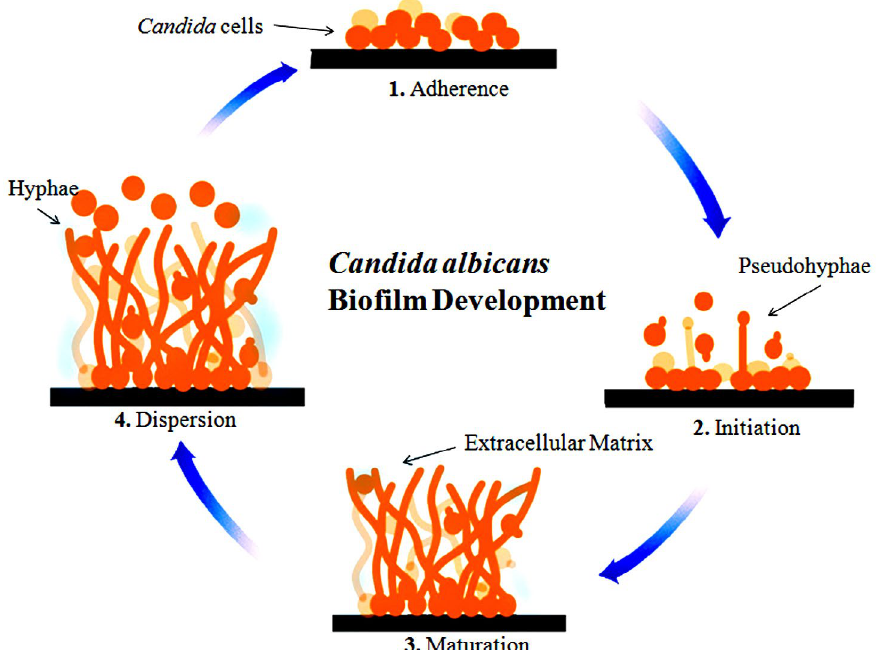
Fig. 1. Better describe the development of different phases such as early, intermediate and Mature. Adhesion and germination occurred in the early phase. Hyphal development as well as Extra cellular material production in the intermediate phase and the last one is maturation phase, in which dispersal occurred. In this Fig. light blue color represent ECM, circle correspond to Candida albicans cells, hyphae is also able to be